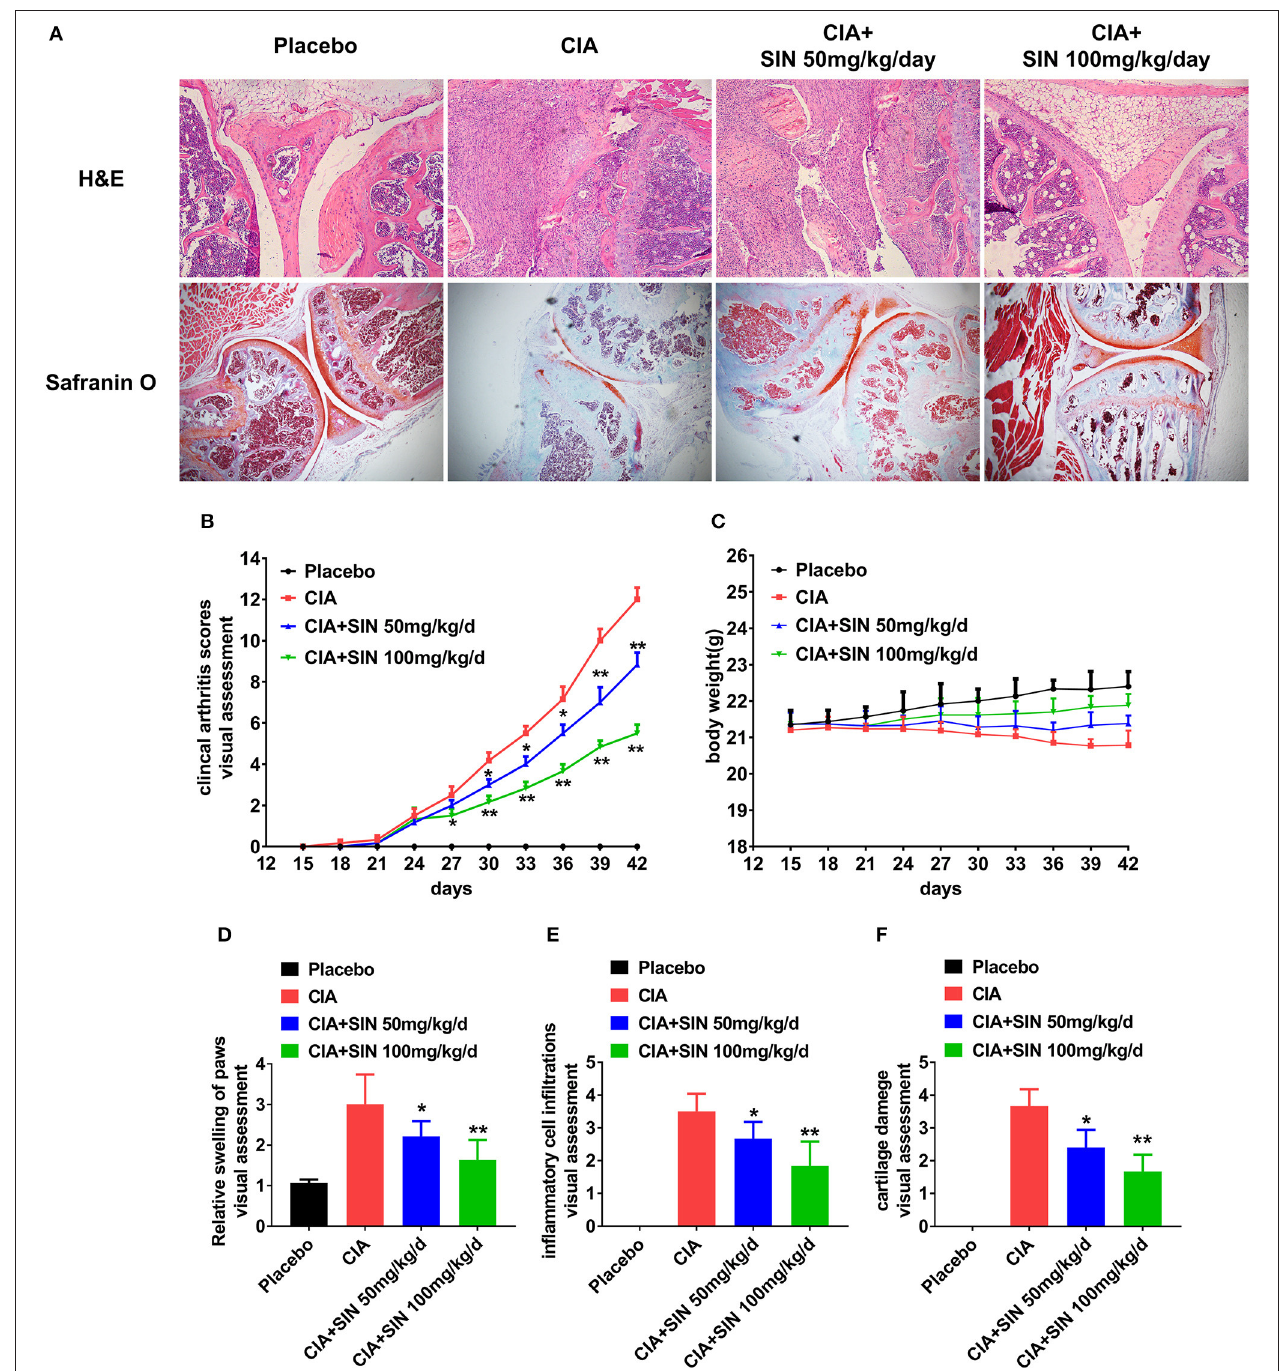
FIGURE 4 | SIN rescues inflammation and cartilage damage in collagen-induced arthritis DBA/1 mice. (A) H&E staining and Safranin-O staining of the ankle joints of each group. (B) Clinical arthritis score was evaluated every 3 days in each group. From day 30 after immunization or the first time, SIN could ameliorate clinical arthritis scores of CIA. The values represent the means ± SD ( n = 6). Significance was analyzed by Wilcoxon rank-sum test (* P < 0.05, ** P < 0.01). (C) Body weight from each group had no significant difference. However, SIN slightly led to body weight gain in CIA mice. The values represent the means ± SD ( n = 6). Significance was analyzed by unpaired 2-sided t -test. (D) Swelling of paws, (E) inflammatory cell infiltrations, (F) cartilage damage could also be attenuated by SIN. Data are presented as the mean ± SD ( n = 6). Significance was analyzed by Wilcoxon rank-sum test (* P < 0.05, ** P < 0.01).